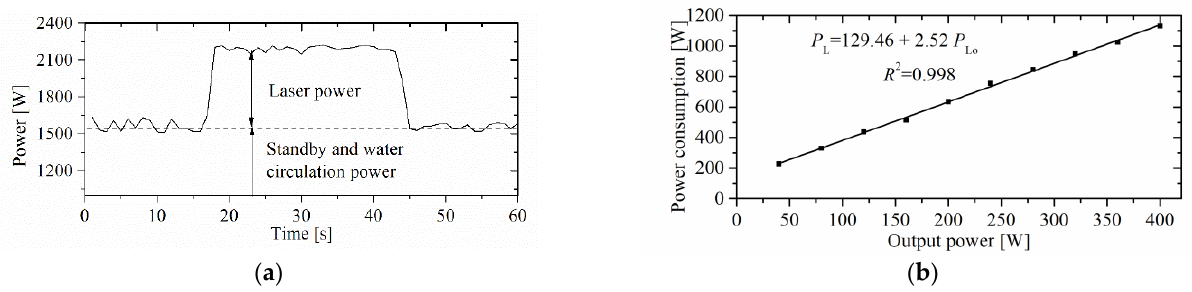
Figure 11. Power consumption of a single laser operating at various output power levels: ( a ) Power profile (output laser power: 200 W); ( b ) Power models.